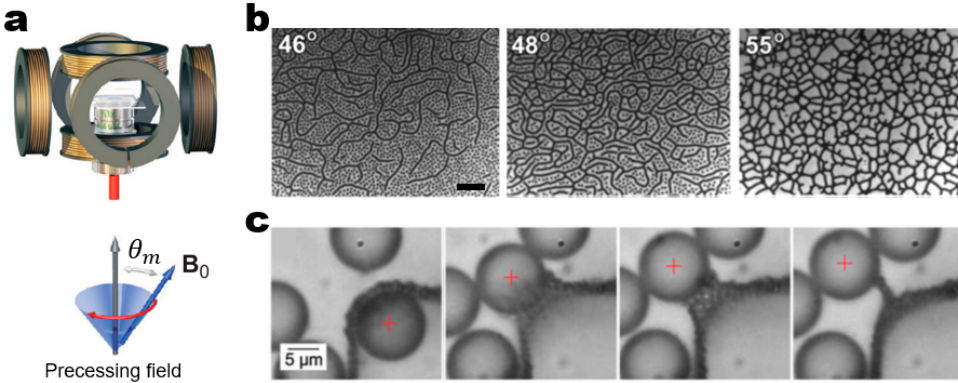
Figure 10. Field-driven dynamic structuring in a precessing magnetic field. ( a ) Schematic of the experimental setup for a triaxial magnetic field: (top) Schematic illustrating a set of three orthogonal pairs of Helmholtz coils that can be used to generate a triaxial magnetic field. (bottom) Schematic representation of a precessing field where θ m indicates the precessing angle. Reproduced with permission [71]. Copyright 2009, American Physical Society. ( b ) Types of percolated network structures assembled from 1.05 µ m superparamagnetic particles depending on the precessing angle. The degree of percolation increases with increasing the precessing angle: (left) percolated long chains at the precessing angle of 46 ◦ , (middle) percolated networks at the precessing angle of 48 ◦ , and (right) froth-like structure at the precessing angle of 55 ◦ . Scale bar: 10 µ m. Reproduced with permission [74]. Copyright 2014, American Chemical Society. ( c ) The self-healing property of one-particle-thick membrane formed from 1.05 µ m superparamagnetic particles. The magic-angle precessing magnetic field drives the consolidation of membranes via the coarsening of network structures. The membrane spontaneously self-heals when a 9 mm silica particle is passed through the membrane by laser tweezers (indicated by the red cross). Reproduced with permission [71]. Copyright 2009, American Physical